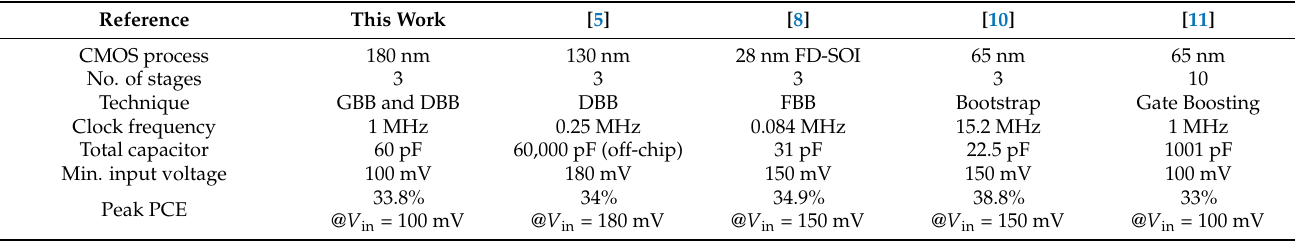
Table 1. Performance summary and